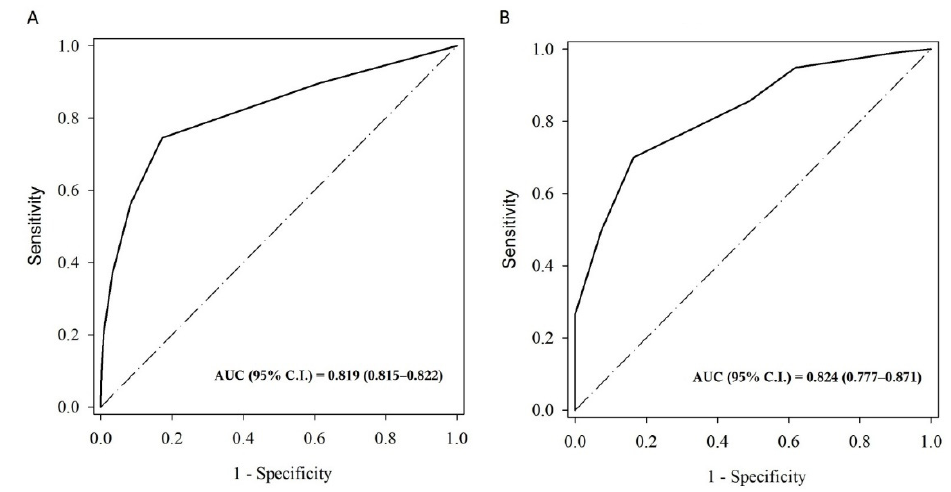
Figure 3. ROC curves in the prediction of major adverse cardiovascular events in non-AF ( A ) and AF ( B ) patients with pneumonia. AUC, areas under the curve; AF, atrial fibrillation; ROC, receiver operator characteristic.